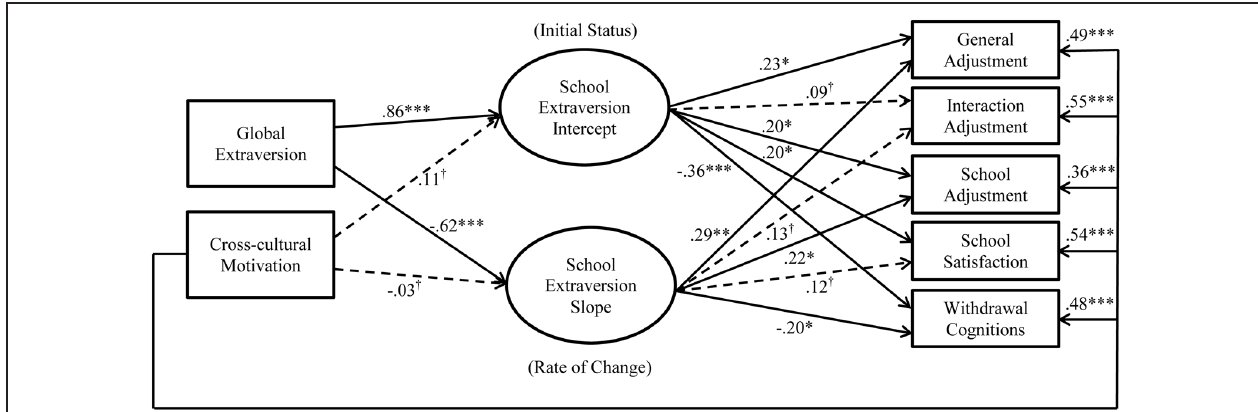
FIGURE 5 | Results from Model 2 with direct paths from cross-cultural motivation to cross-cultural adjustment outcomes. ∗ p < 0.05; ∗∗ p < 0.01; ∗∗∗ p < 0.001; † p ≥ 0.05; N = 215. Estimates are standardized estimates from Model 2 (i.e., the unconstrained model). Observed measures of school extraversion were included in the model but not presented here. Solid lines represent significant paths, whereas dotted lines represent insignificant paths.